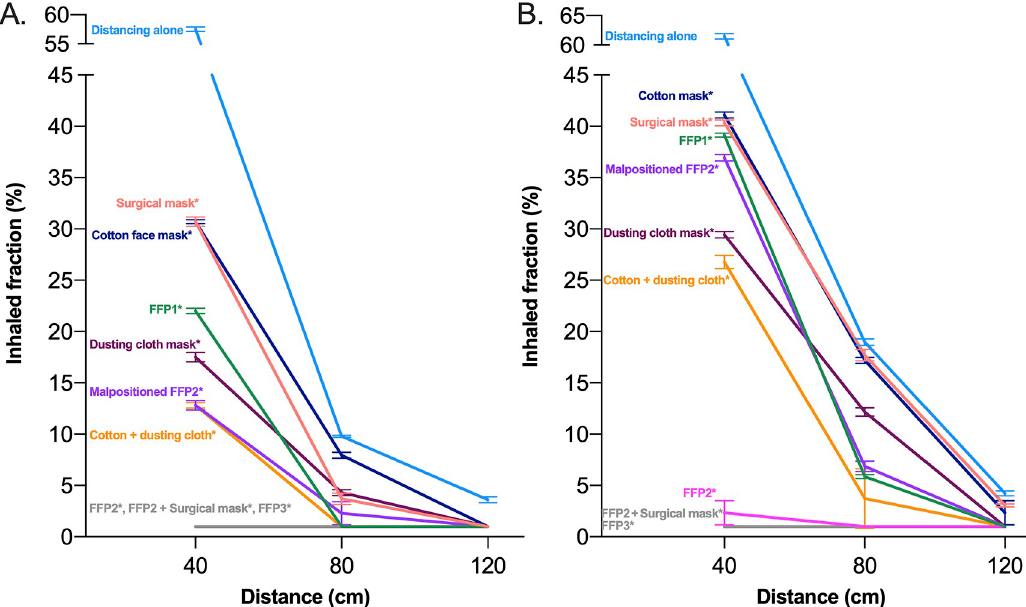
Fig 4. Effect of distance from the emitter on inhaled fraction with different masks during normal (A) and polypneic (B) pattern of breathing. � Significant difference compared to distancing alone (p < 0.001).